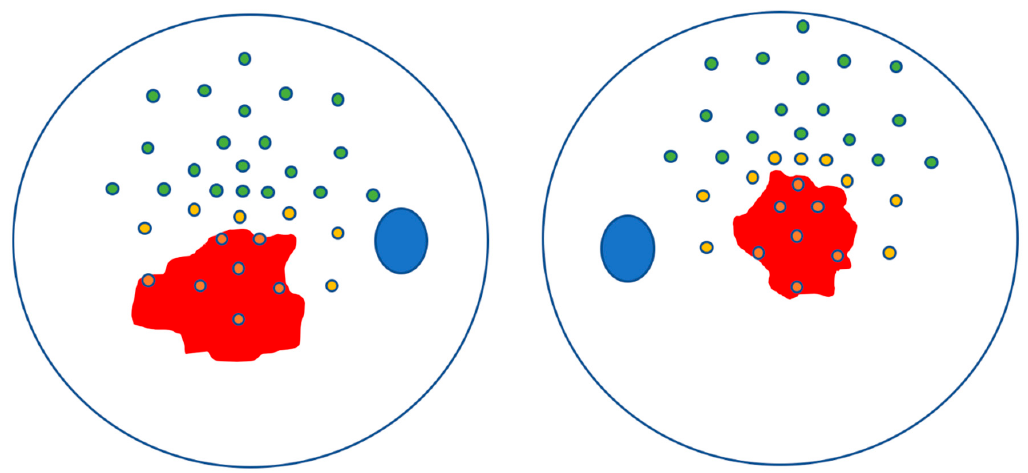
Figure 2. An example (outside atrophy (OA) of patient 1) of the sub-classification of the outside atrophy microperimetry points in near atrophy (NA) (in yellow) and distant from atrophy (DA) (in green). In red the atrophic area with the included points in orange.